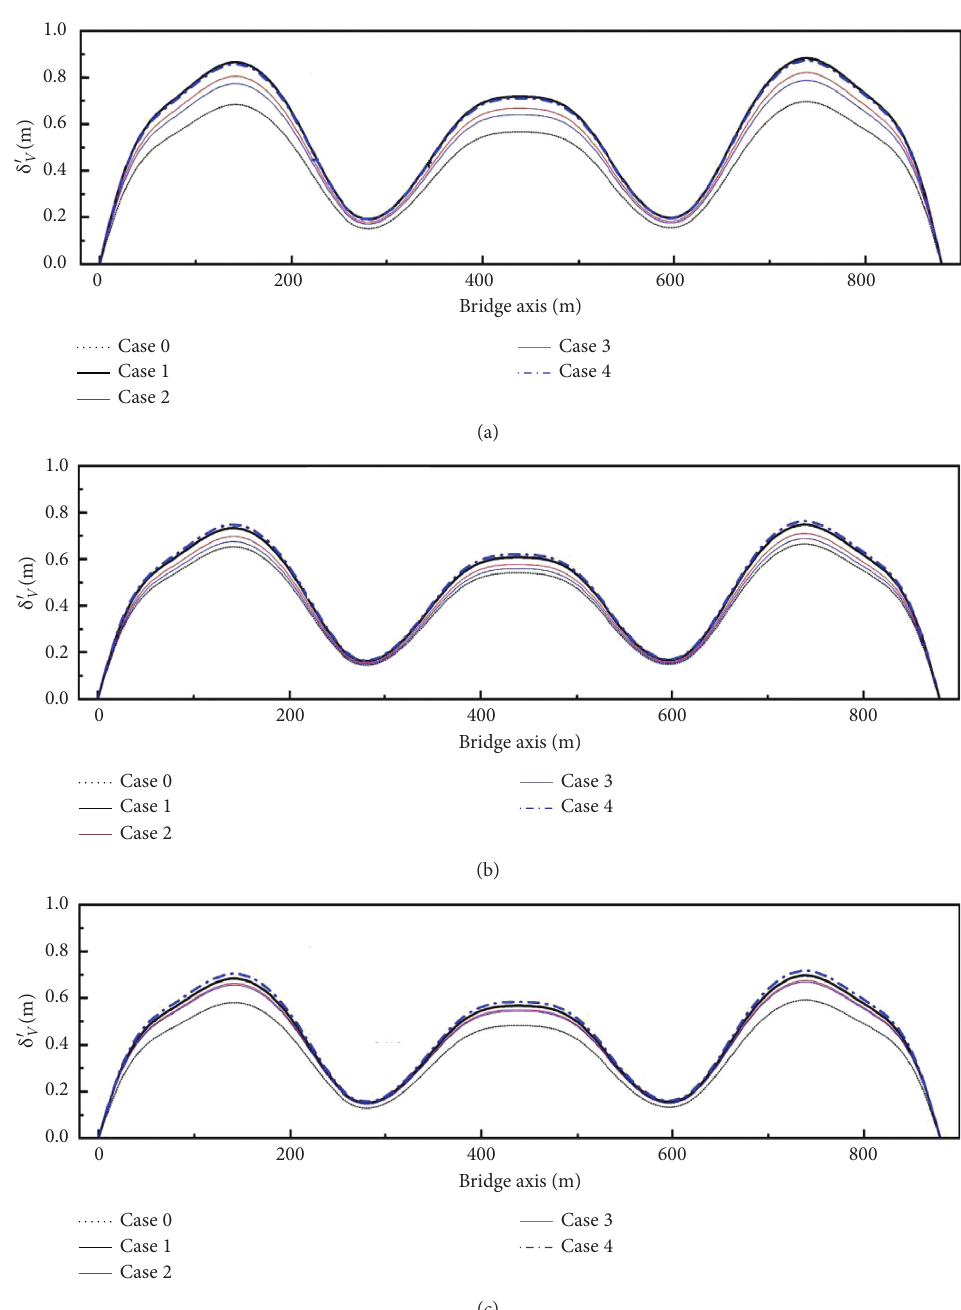
Figure 18: RMS vertical buffeting displacements of all the investigated cases at different AoAs: (a) AoA � 0 ° ; (b) AoA � +5 ° ; (c) AoA � − 5 °